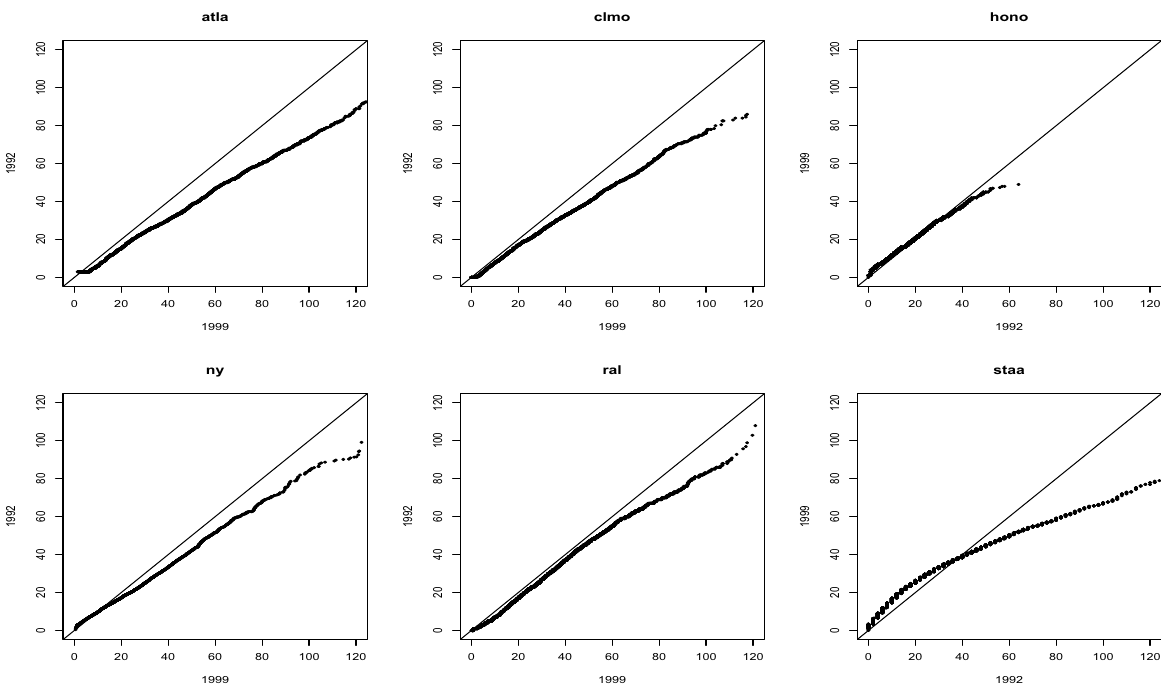
Figure 1. QQ-plots of high ozone levels in 1992 under baseline conditions against low ozone levels in 1999 under attainment conditions at six different